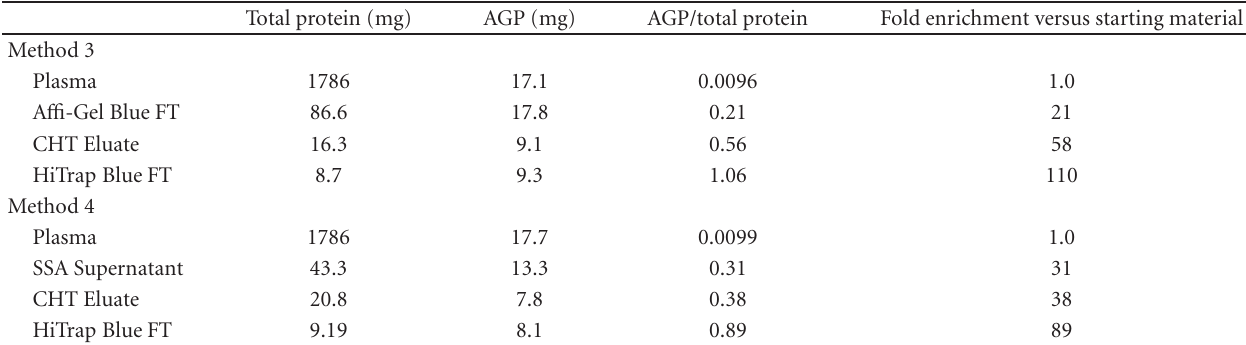
Figure 3: Comparison of AGP purified by solely chromatographic Method 3 or sulphosalicylic acid-incorporating Method 4. (a) and (b) show Coomassie-stained SDS reducing gels of equivalent (5 μ g total protein/lane) samples of AGP preparations at intermediate steps of either Method of AGP purification: A ffi -Blue FT, Cibacron Blue dye column flow-through, CHT, ceramic hydroxyapatite peak; HT A ffi - Blue, HiTrap Cibacron Blue dye column flow-through; SSA Sup., supernatant following sulphosalicylic acid precipitation and neutralization. (c) depicts nitrocellulose blots of replicated gels containing 1.0 μ g of purified human serum albumin (HSA) or of AGP purified by either Method 3 (M3) or Method 4 (M4) and probed either with Anti-AGP antibodies (at left) or Sambucus nigra agglutinin (SNA lectin) at left. The position of molecular mass markers and their mass in kDa is shown at left of each panel. Table 1: Comparison of stepwise purity and yield of AGP purification